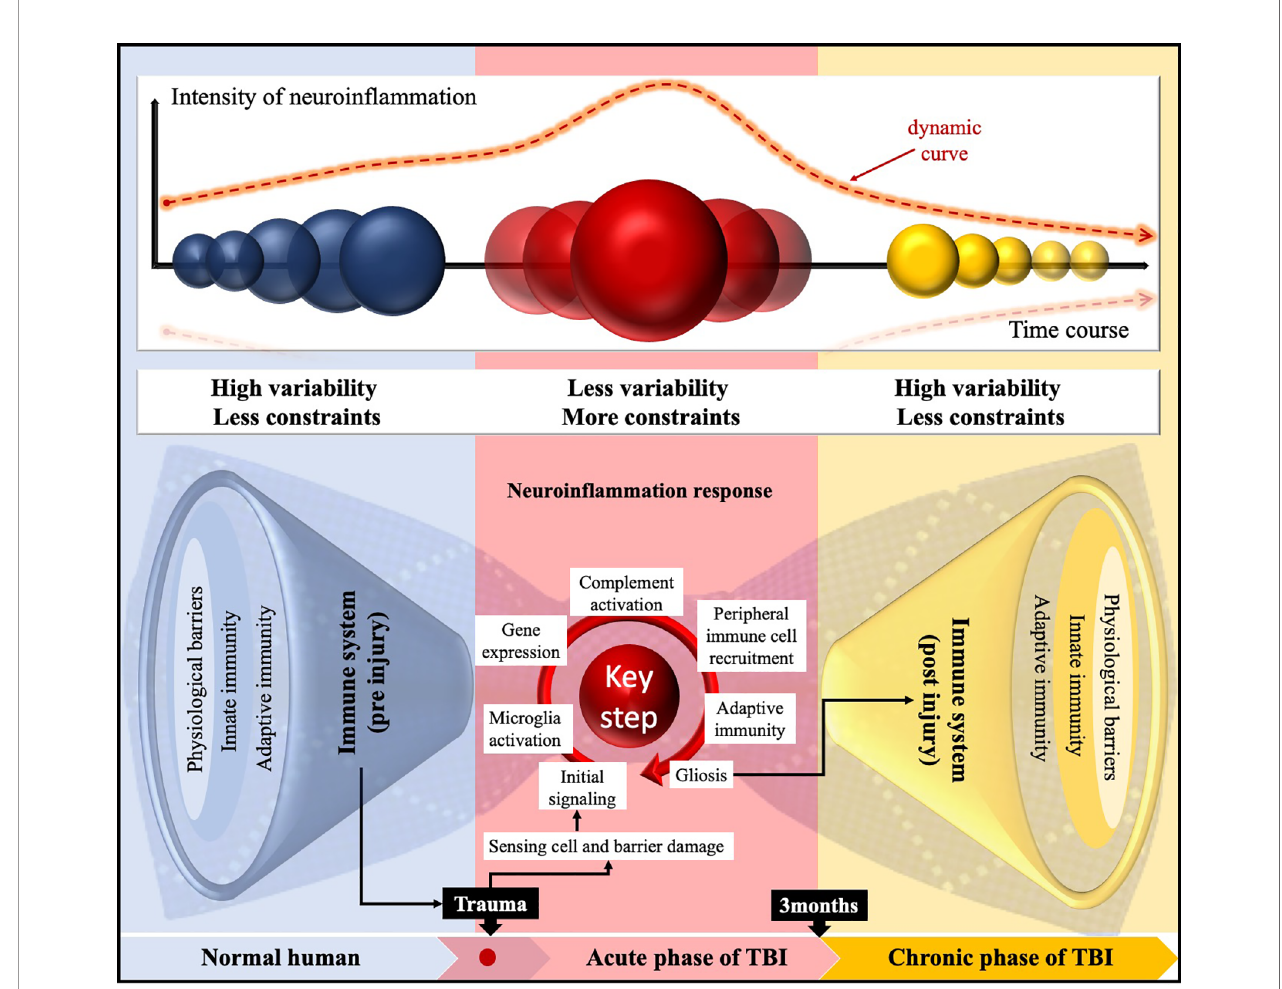
FIGURE 3 | Schematic representation of the time-related paradigm shift in neuroin fl ammation following TBI employing a bow-tie paradigm. The characteristic of immunogenicity in the CNS was high variability and fewer constraints pre-TBI. Then, in the core, the neuroin fl ammation is “ compressed ” by relatively regular rules or steps and processed into chronic neuroin fl ammation following TBI. Notably, there was a dynamic course of the functional diversity; temporal intensity of response; and dynamic changes in in fl ammatory gene expression, cell activation, and their interaction